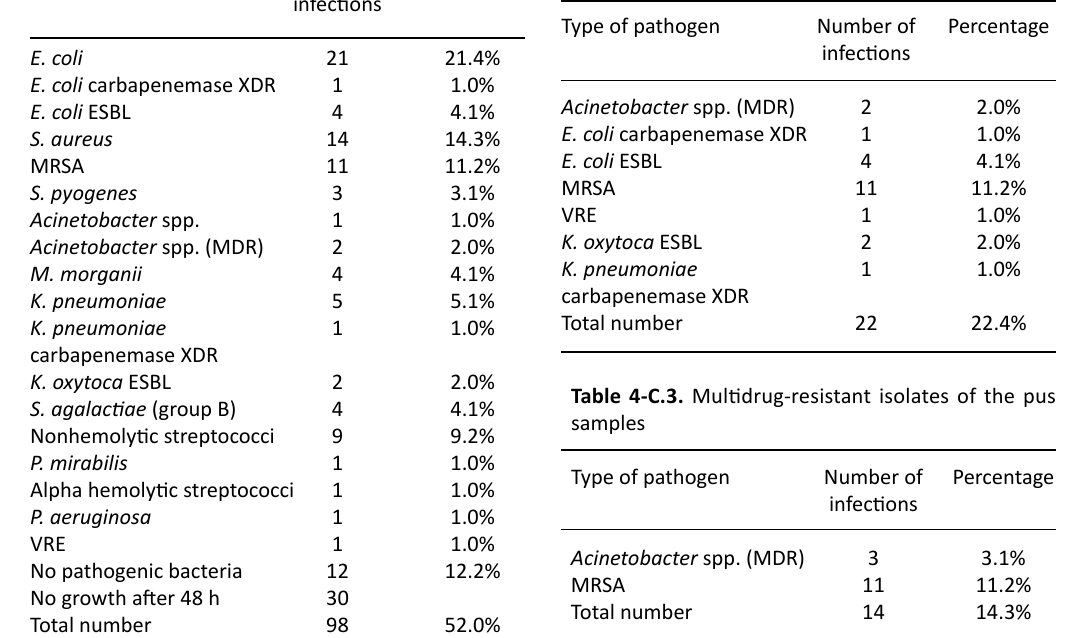
Table 4-c.1. Pathogenic agents of the pus samples Type of pathogen